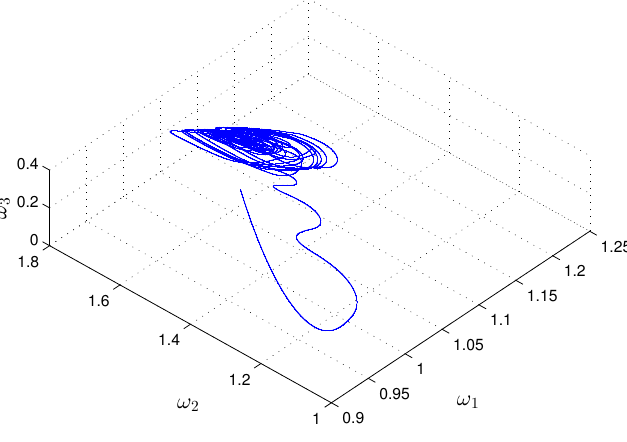
Figure 2. The irregular trajectory of the solution ω ( t )